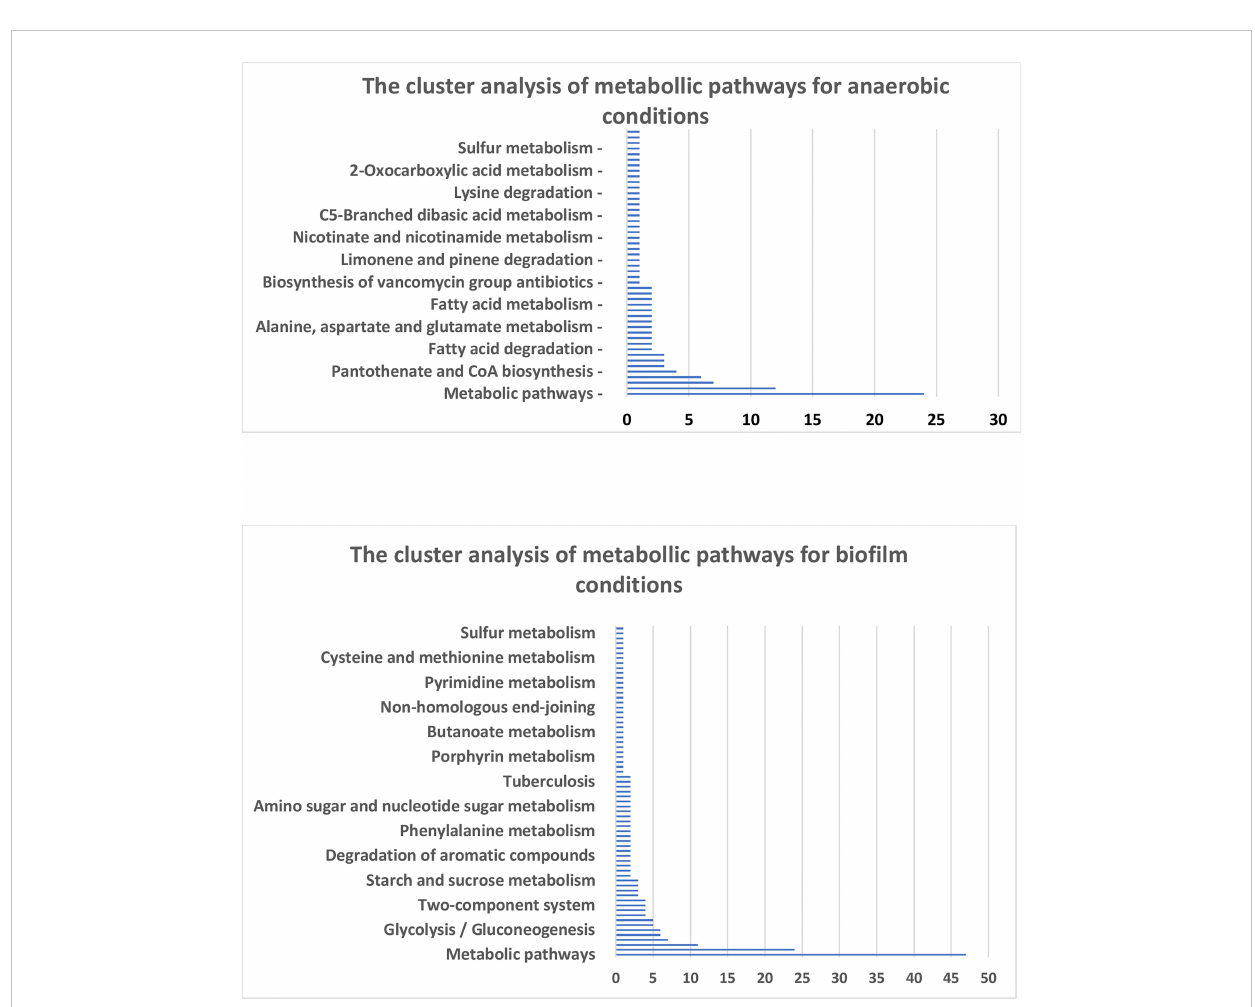
FIGURE 3 Charts represent the KEGG enrichment analysis of metabolic pathways for the corresponding